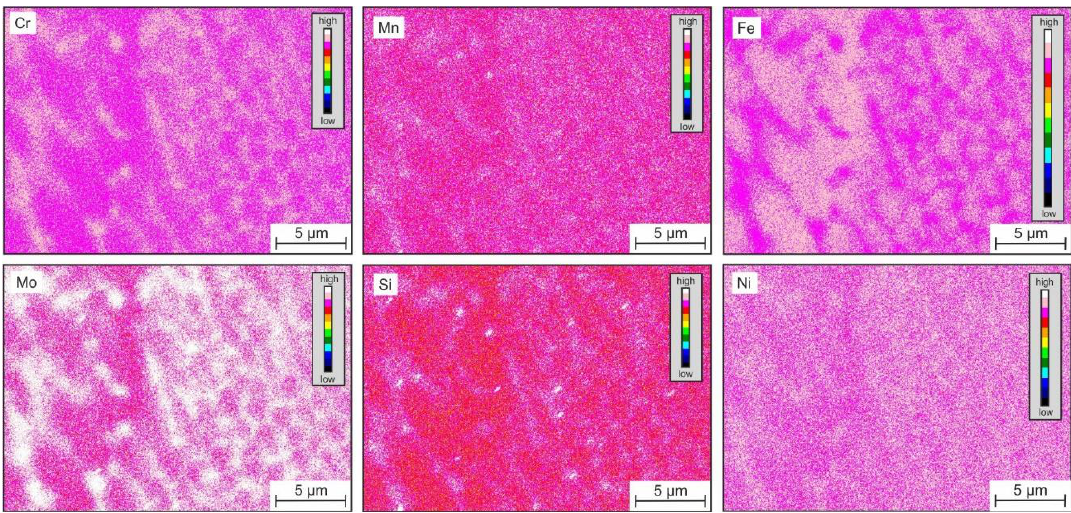
Figure 5. Electron backscatter diffraction analysis (EBSD) images (ND-IPF, parallel to the longitudinal axis of the directional solidification (DS) specimen) of the investigated microstructures. The cellular substructures and inclusions after LMD processing are shown in backscattering electron contrast (BSE).